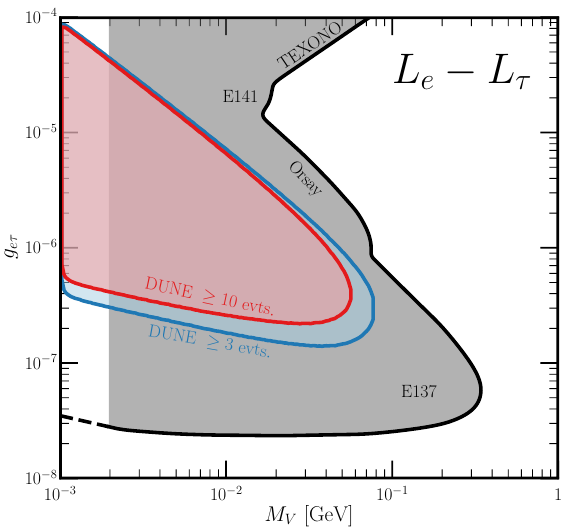
Figure 13 . Expected sensitivity at the DUNE MPD to L e (blue) indicates more than ten (three) signal events expected in ten years, a background-free search. Existing limits in this parameter space are in grey. The dashed line for small M V and g e(cid:28) indicates our extrapolation of existing